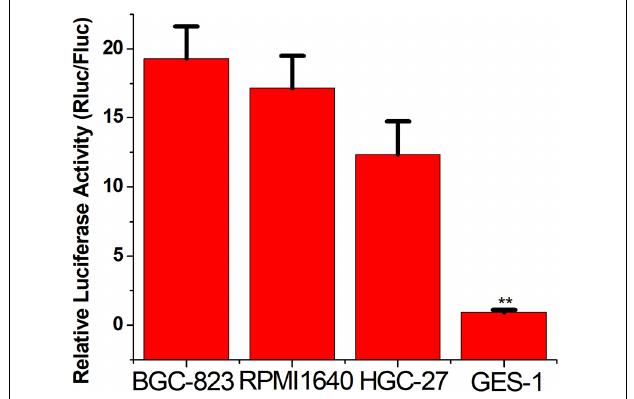
FIGURE 5 | Specifically inhibited cancer cell proliferation. Cell proliferation rate was determined using the CCK-8 assay (** p < 0.01). Data were expressed as mean ±